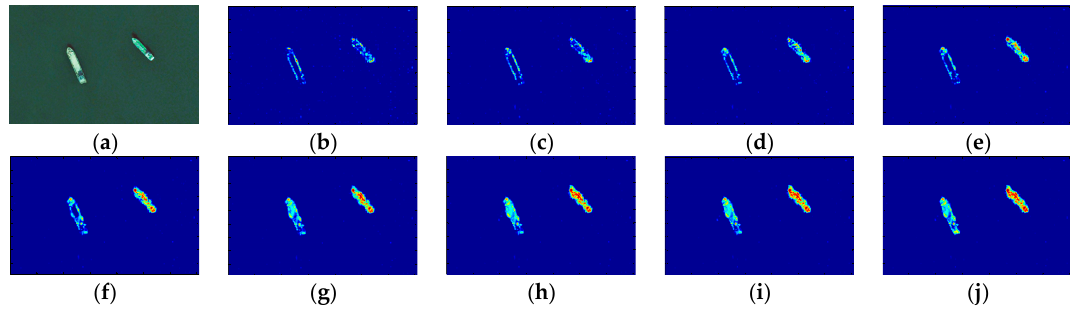
Figure 5. Multi-level maps: ( a ) input image; ( b ) j = 1; ( c ) j = 2; ( d ) j = 3; ( e ) j = 4; ( f ) j = 5; ( g ) j = 6; ( h ) j = 7; ( i ) j = 8; and ( j ) j = 9.